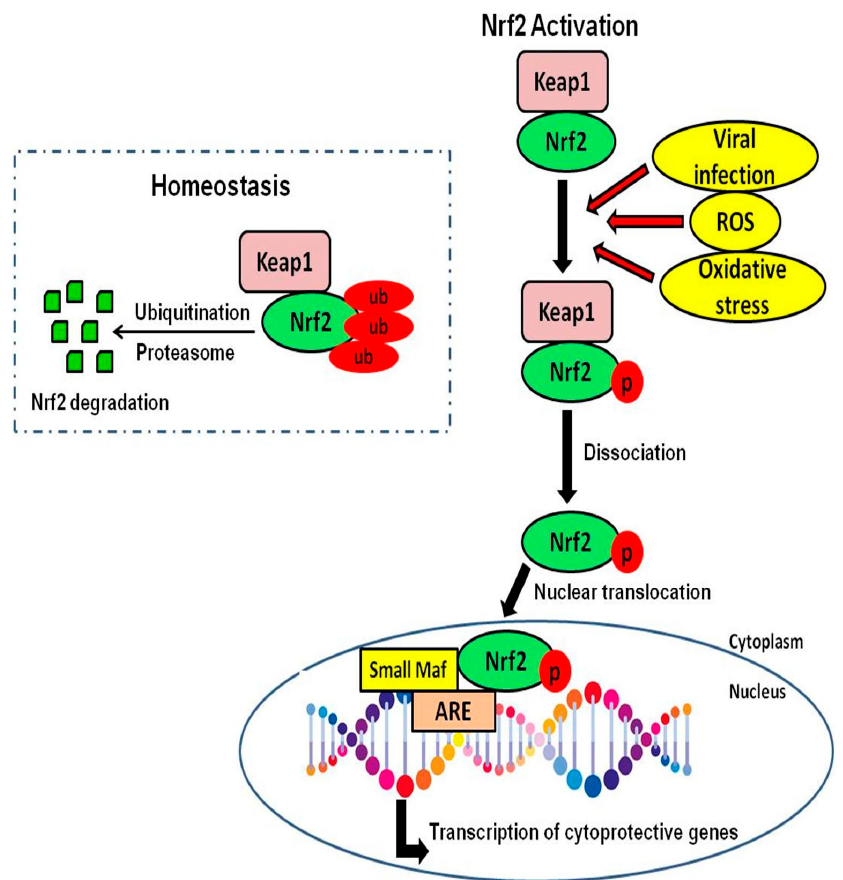
Figure 1. Nrf2 activation. The diagram shows the Nrf2-Keap1 inhibitory complex in homeostasis state and Nrf2 activation under stressful conditions, leading to the transcription of cytoprotective genes.